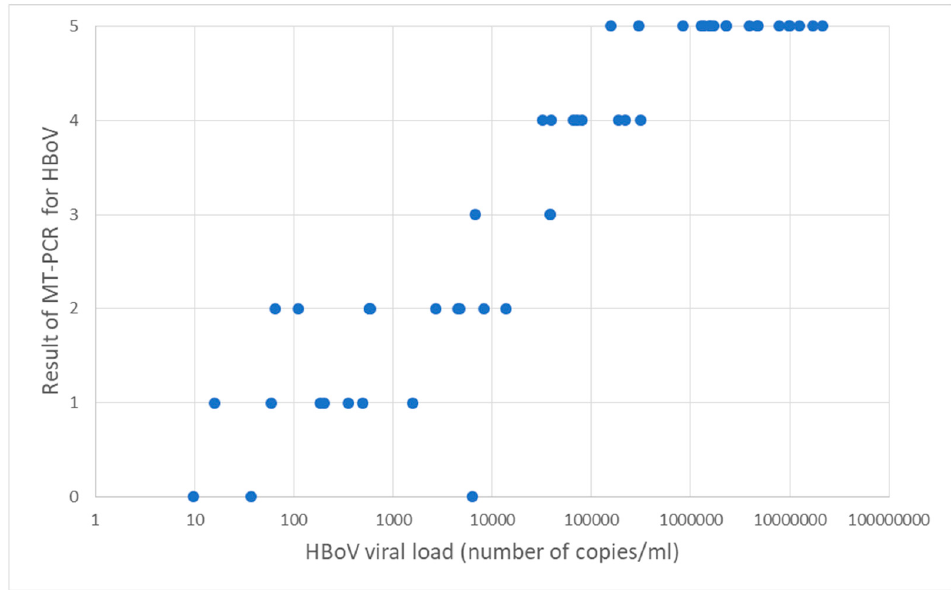
Figure 3. Comparison of 5-star based representation on MT-PCR (intensity) and quantitative HBoV PCR: x axis represents concentration of HBoV by quantitative PCR and y axis number of stars on MT-PCR test.